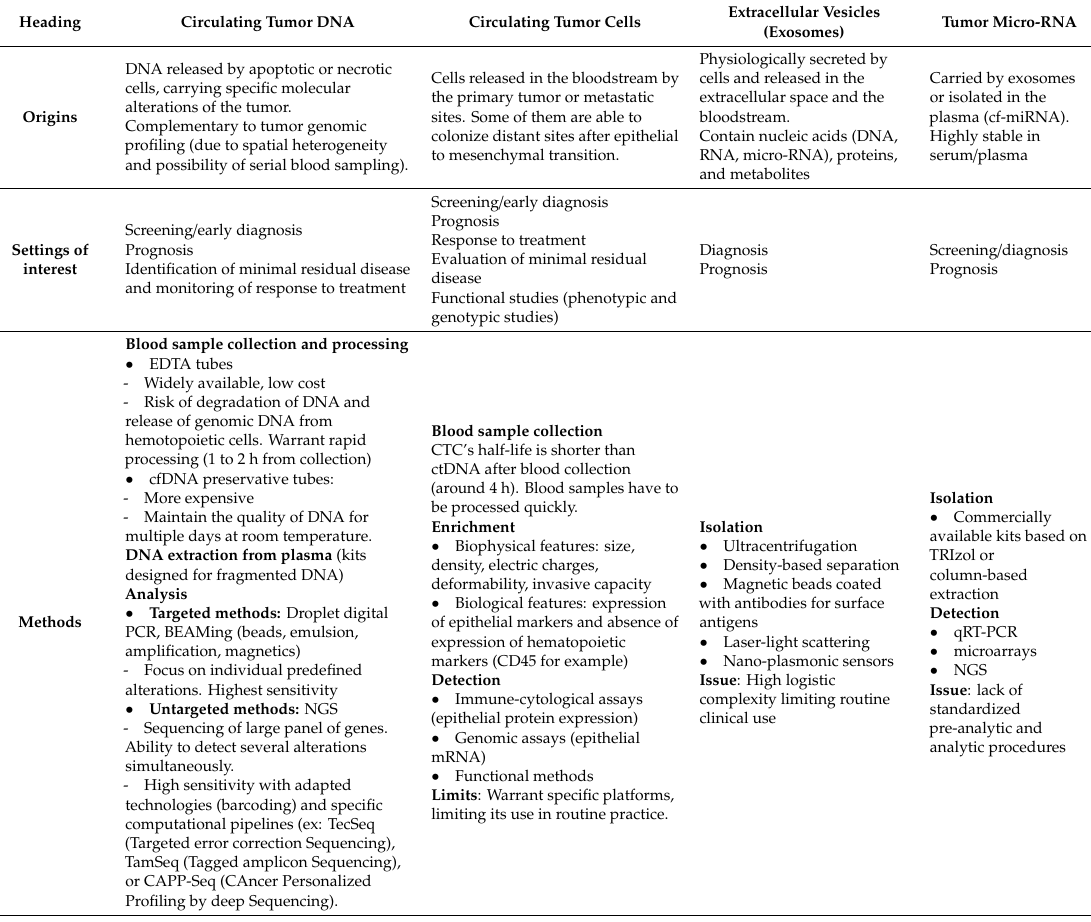
Figure S1: PRISMA diagram, Table S1: PRISMA